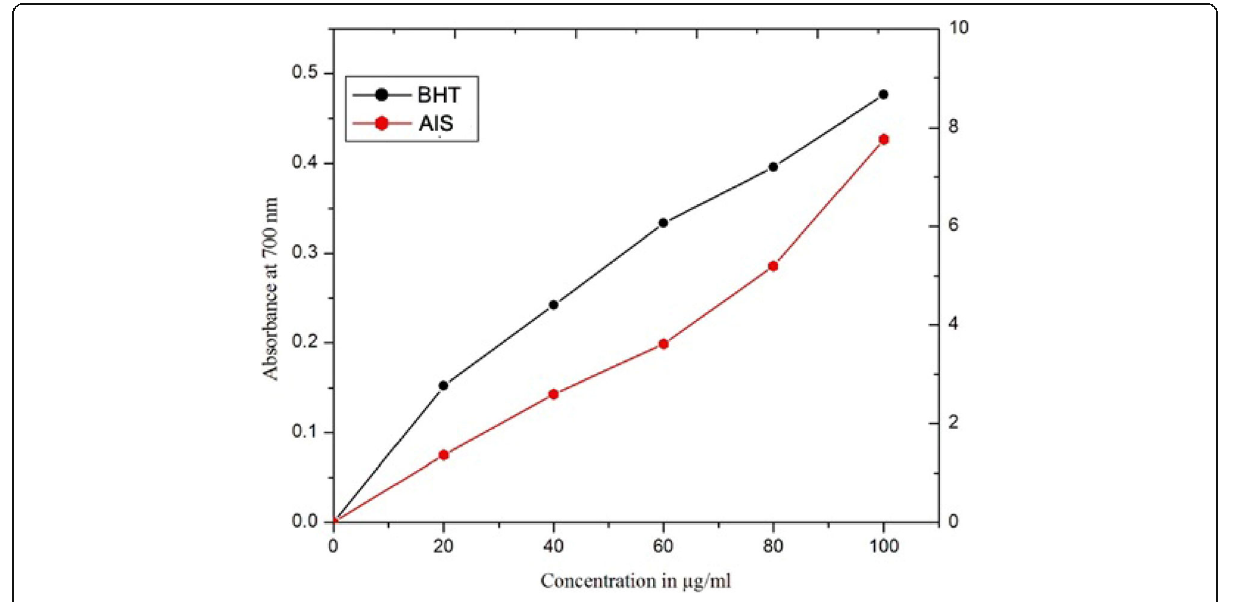
Fig. 2 Reducing power of AIS compared with BHT. Each value is expressed as the mean ± standard deviation ( n =